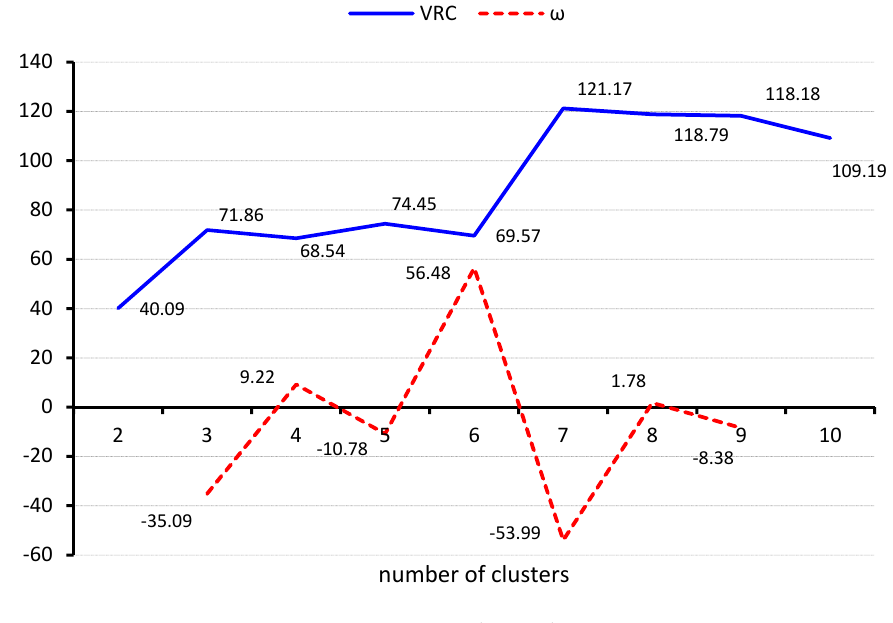
Figure 3. VRC and ω analysis. Table 4. Analysis of variance.